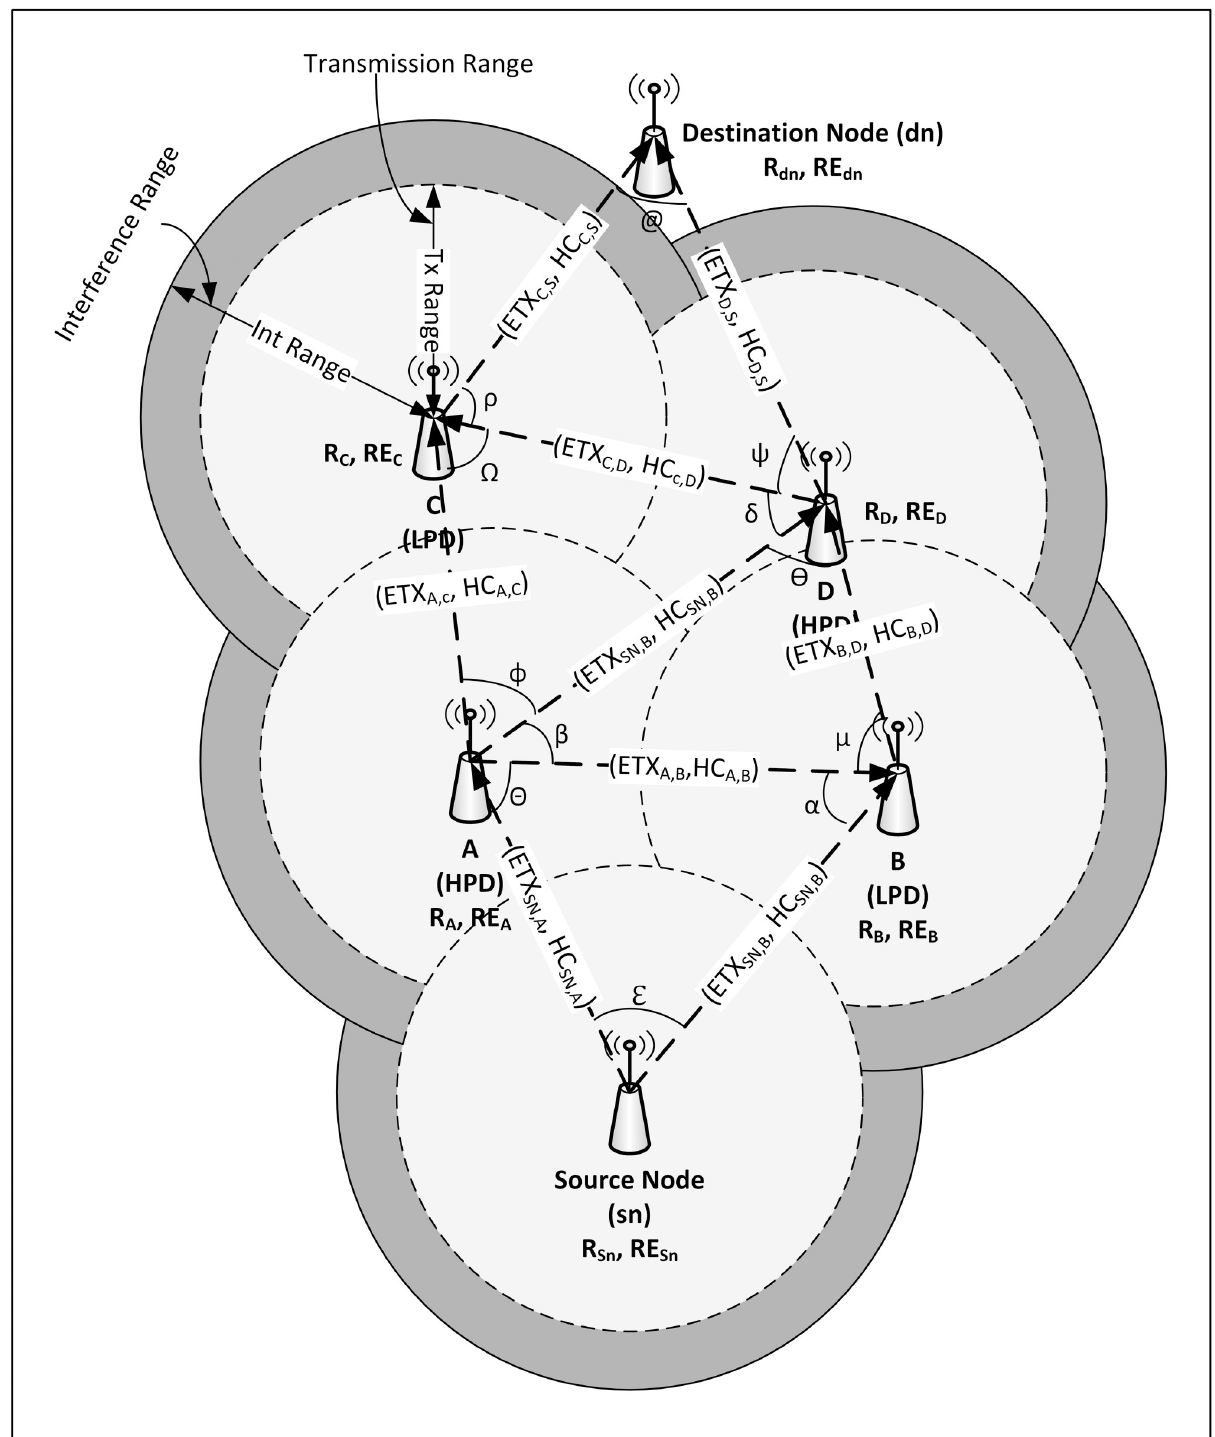
Fig 9. PSPCM routing path computation architecture and